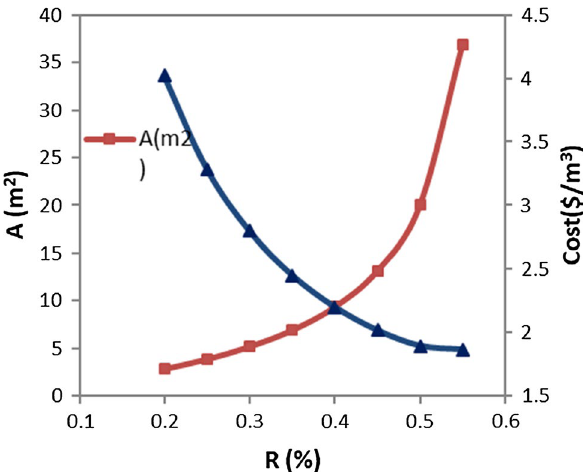
Fig. 4 Evaluating the effect of the recovery ratio (in rang of 0.2–0.55) on the cost and active surface